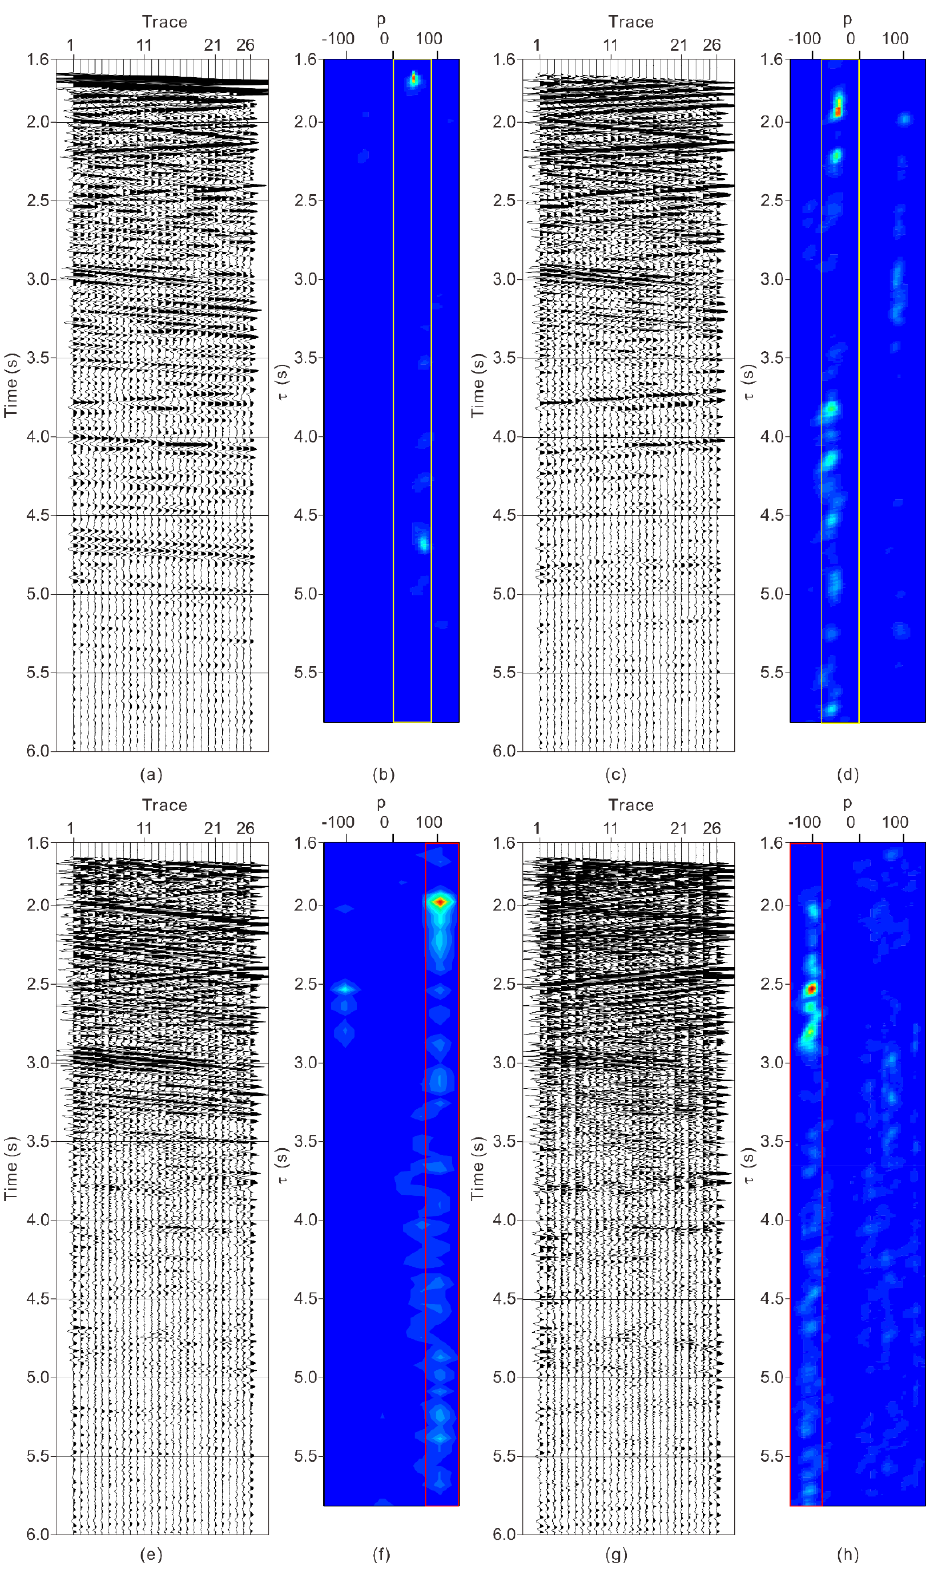
Figure 13. Wavefield data after successive wave separations and the slowness spectrum. ( a ) Original VSP data; ( b ) Slowness spectrum of ( a ); ( c ) Residual wavefield after subtraction of the downgoing P-wave in ( a ); ( d ) Slowness spectrum of ( c ); ( e ) Residual wavefield after subtraction of the upgoing P-wave in ( c ); ( f ) Slowness spectrum of ( e ); ( g ) Residual wavefield after subtraction of the downgoing S-wave in ( e ); ( h ) Slowness spectrum of ( g